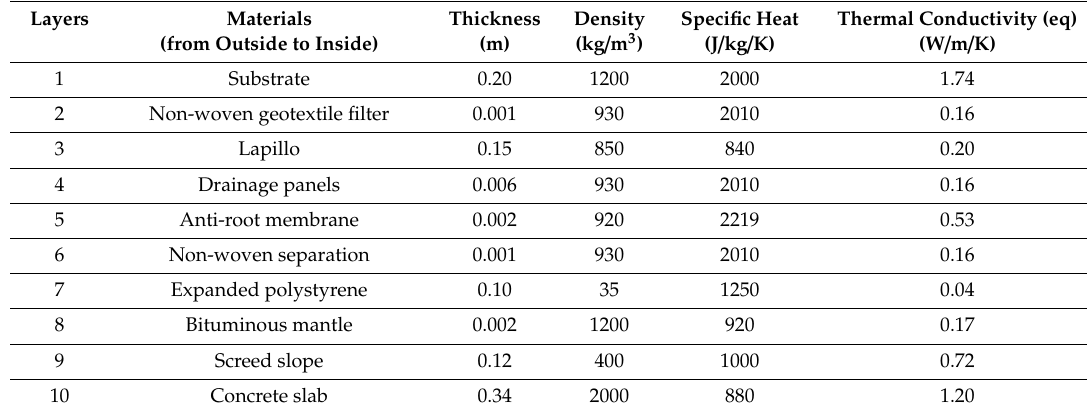
Table 6. Stratigraphy of the intensive thick (thickness: 0.91 cm) green roof.